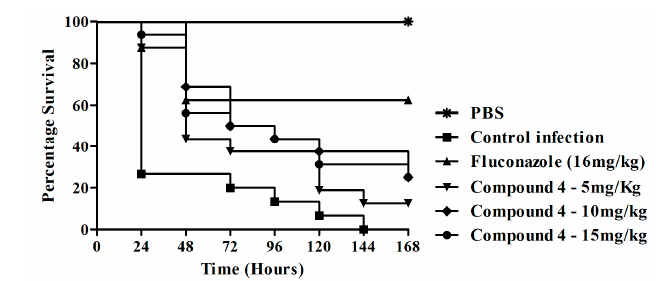
Figure 5. Survival curve of Galleria mellonella . ( A ) G. mellonella infected with C. albicans (CAN14) and treated with thiazolylhydrazone 1 at 5.0 mg/kg ( p < 0.0001); 10 mg/kg ( p < 0.0128) and 15 mg/Kg ( p < 0.005) ( B ) G. mellonella infected with C. albicans (CAN14) and treated with thiazolylhydrazone 2 at 5.0 mg/kg; 10 mg/kg and 15 mg/kg ( p < 0.0001), ( C ) G. mellonella infected with C. albicans (CAN14) and treated with thiazolylhydrazone 3 at 5.0 mg/kg ( p = 0.0005); 10 mg/kg ( p = 0.0002) and 15 mg/Kg ( p = 0.0356) ( D ) G. mellonella infected with C. albicans (CAN14) and treated with thiazolylhydrazone 4 at 5.0 mg/kg ( p = 0.0224); 10 mg/kg ( p = 0.0010) and 15 mg/kg ( p = 0.0026).